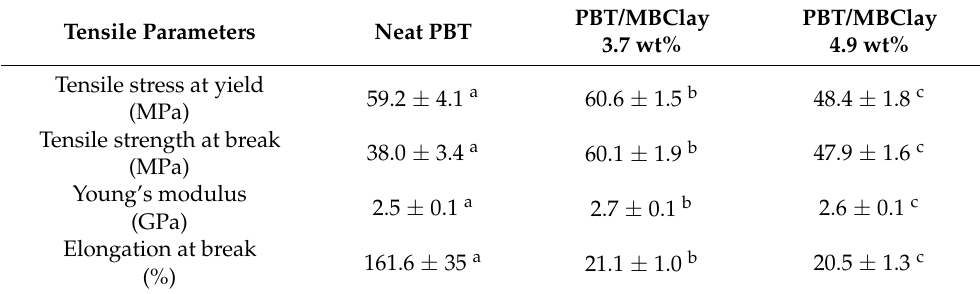
Table 4. Tensile test results for the neat PBT and PBT/MBClay nanocomposites. Tensile Parameters Neat